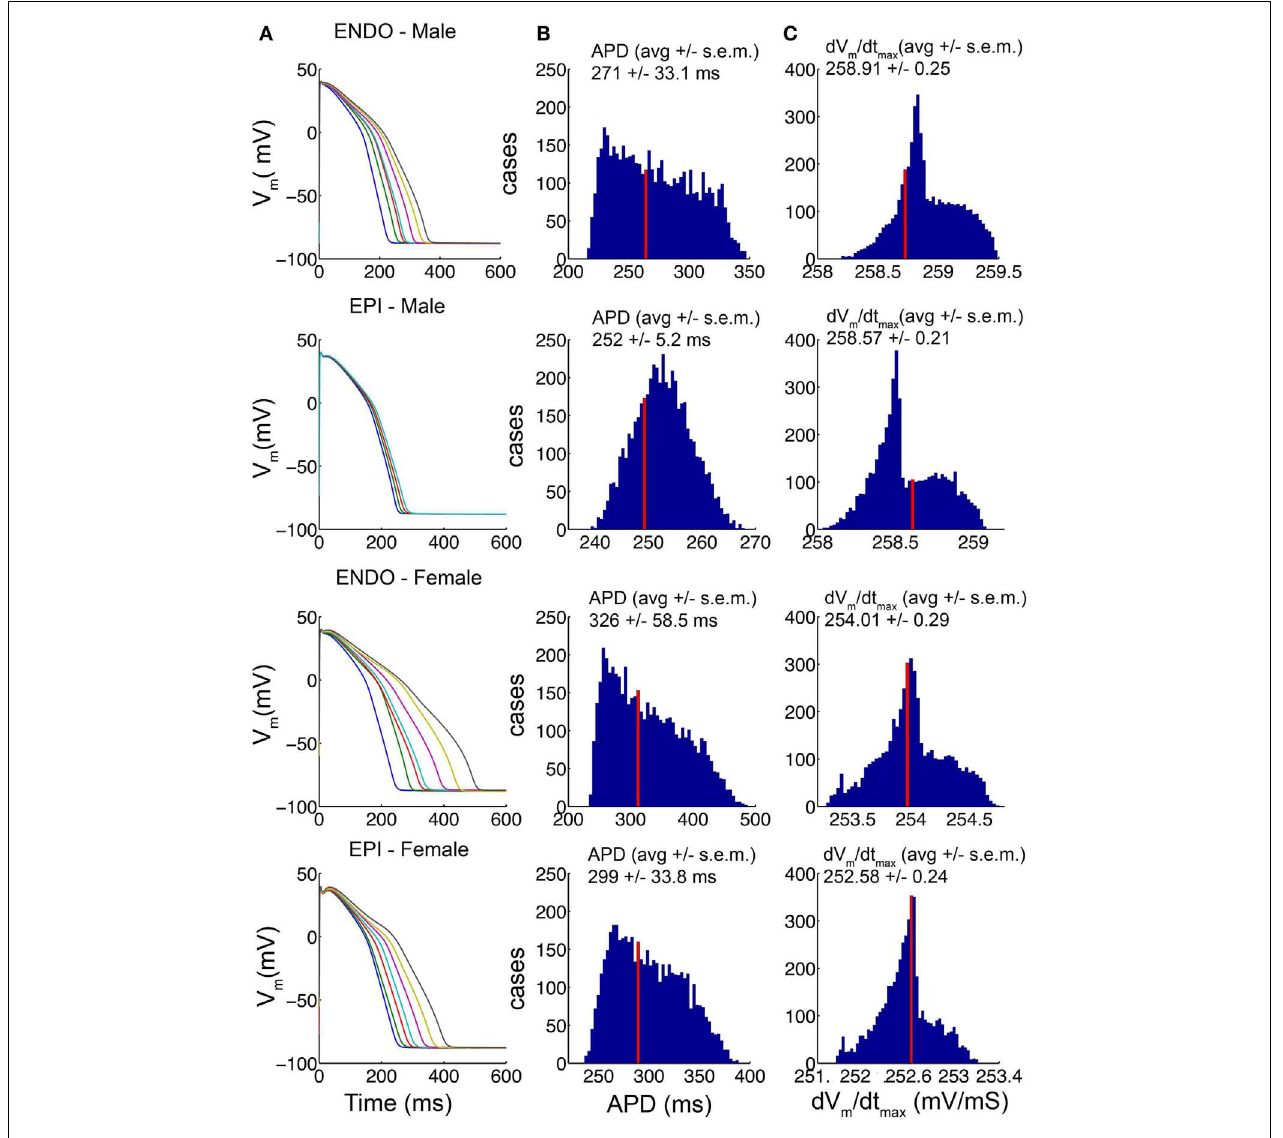
from male and female models are shown (A) .The distributions of APD variations (B) and the distributions of maximum upstroke velocity (C) for each model are shown.The average values are indicated.The index values derived from the mean experimental values are indicated by the red bars.